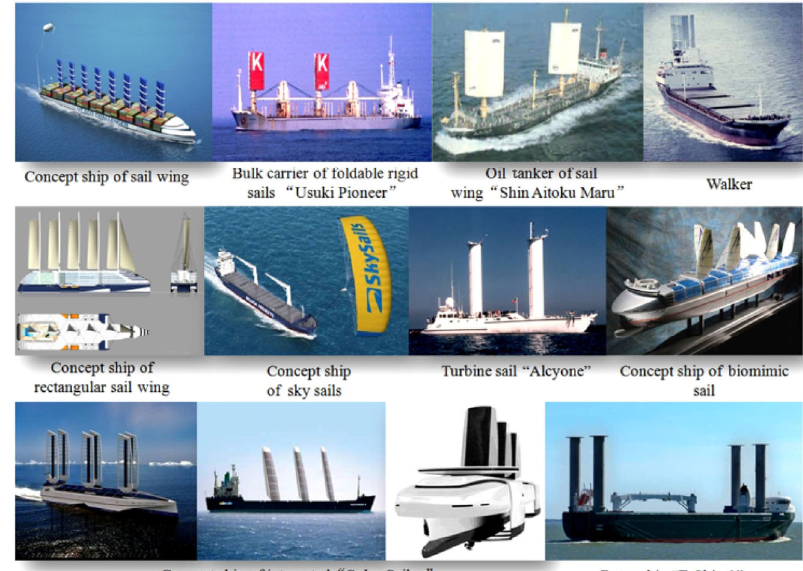
Fig. 4 Various types of sail-auxiliary